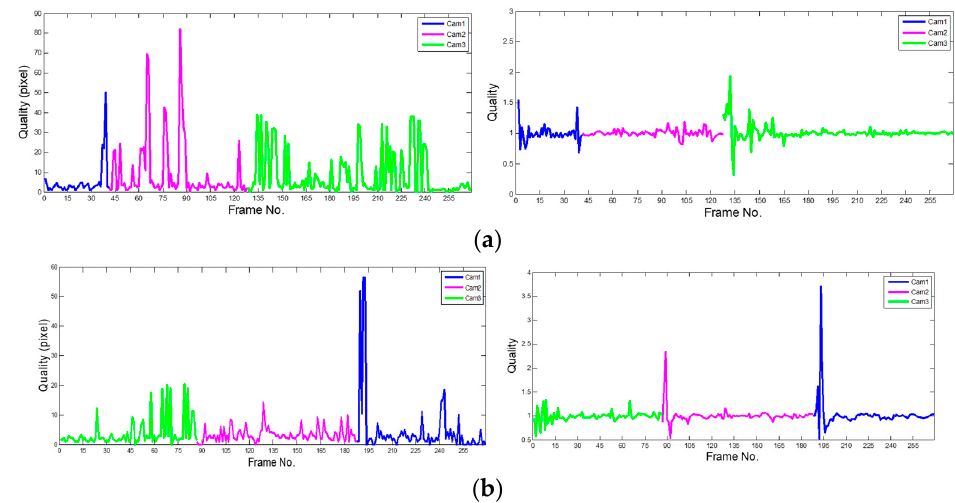
Figure 14. ( a ) MS metrics ( left ) and FIT metrics( right ) of People 1 tracking result in two camera scenes; ( b ) MS metrics and FIT metrics of People 2 tracking result in two camera scenes.